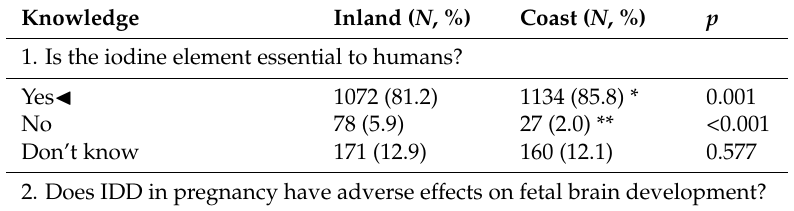
Table 3. Participants’ iodine-related knowledge according to